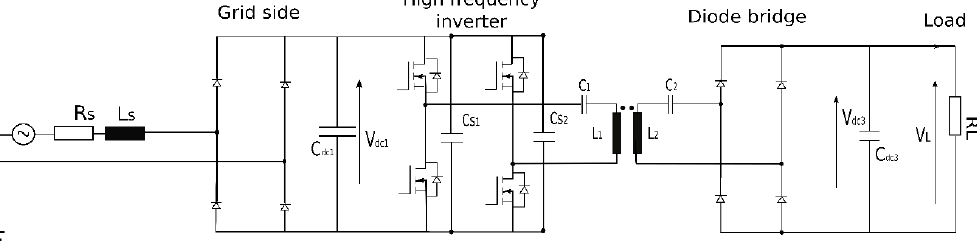
Figure 20. Experimental topology in the lab. Table 4. Parameters of the laboratory testing.